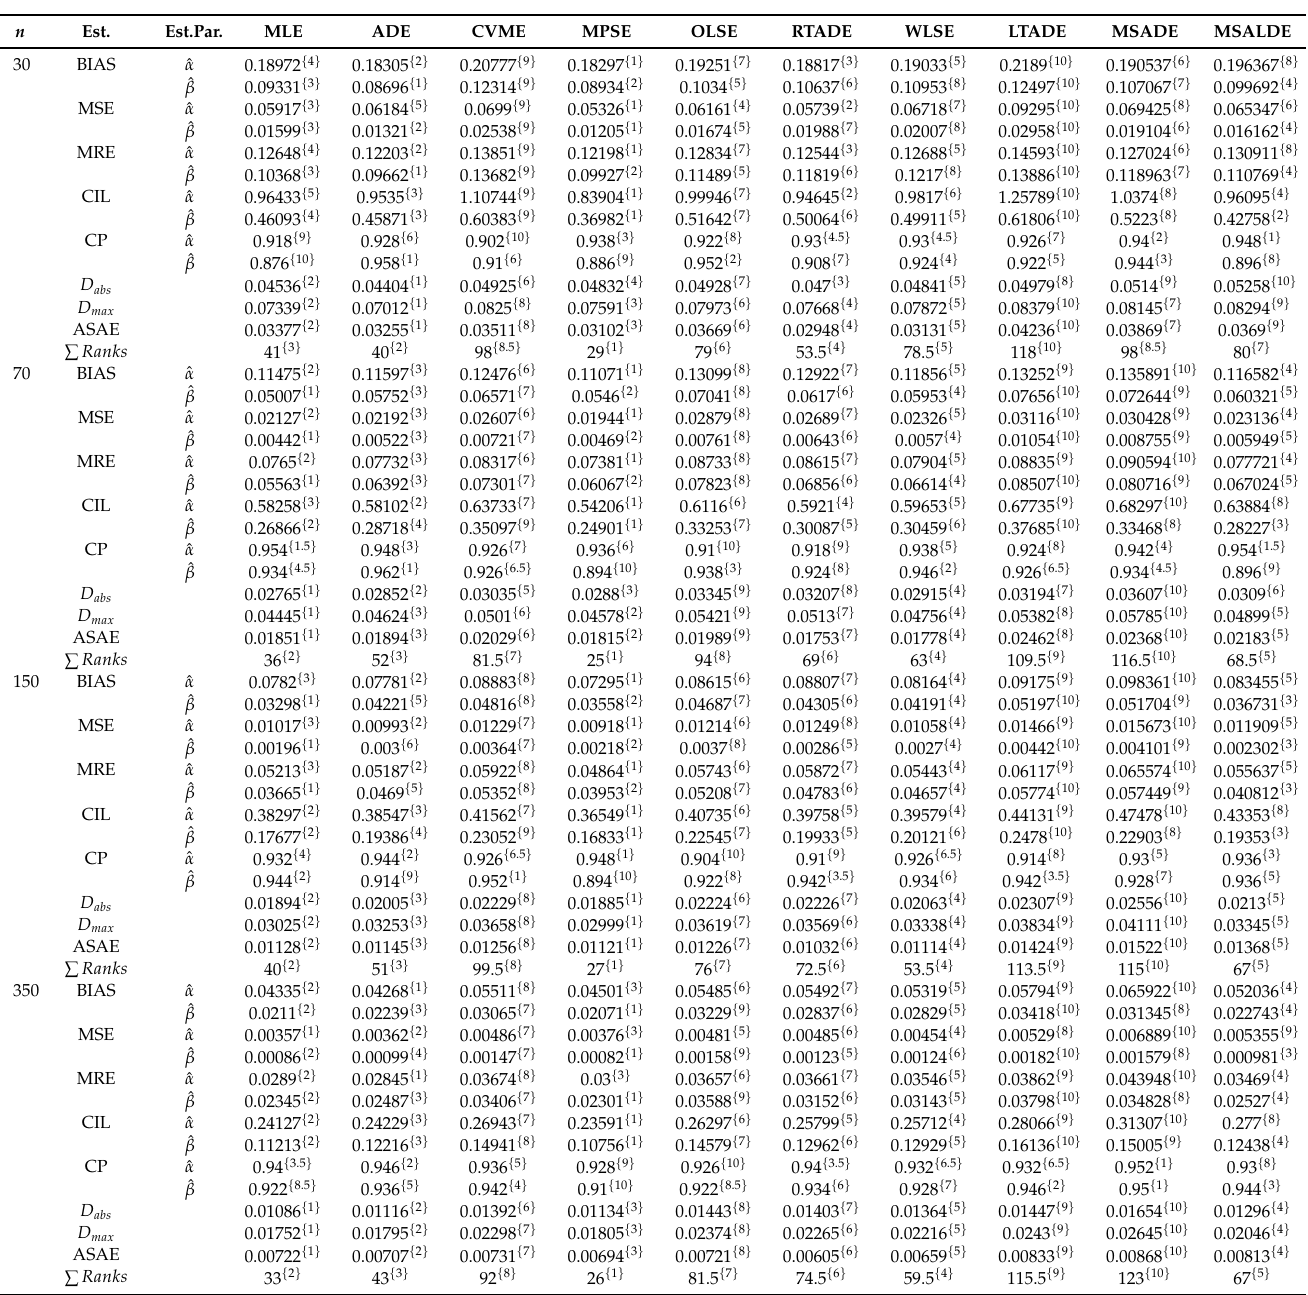
Table 4. Numerical values of PHD simulation for ( α = 1.5, β = 0.9 )